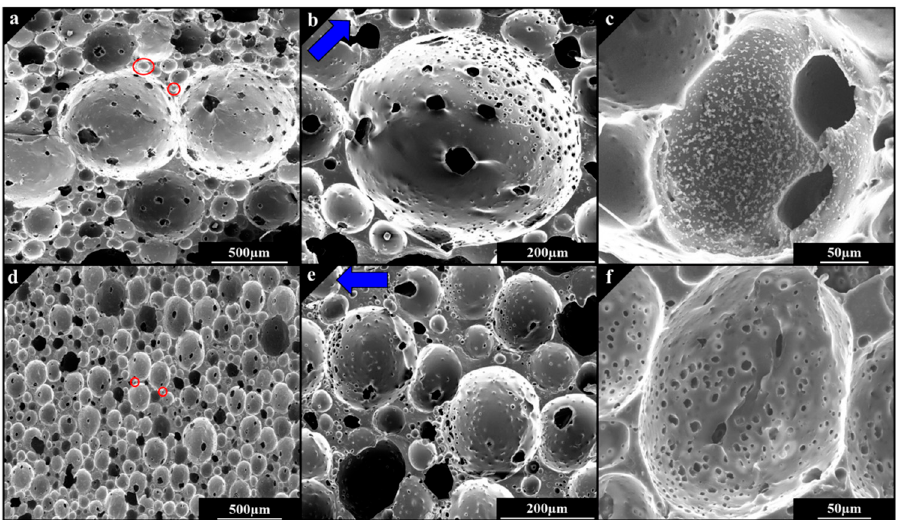
Figure 2. SEM micrographs of cured samples showing the cell perforation and deposits of microspheres of EML227 polyurea foam in the top panel ( a – c ) and EML350 polyurea foam in the bottom panel ( d – f ).